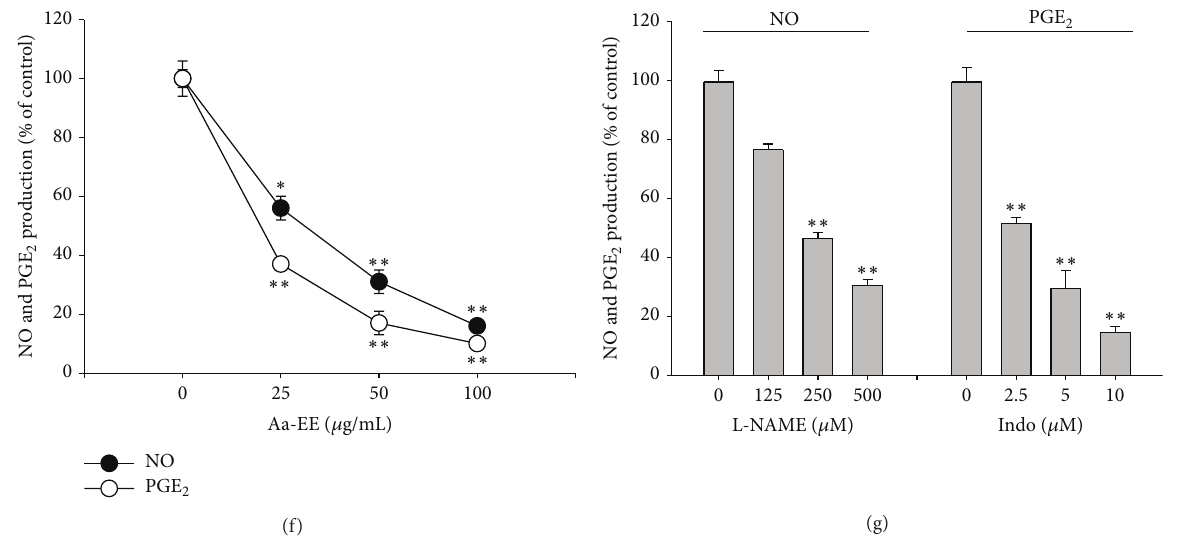
Figure 1: The effects of luteolin on the production of NO and PGE 2 in macrophages, and their viability. (a) Chemical structures of luteolin, eupatilin, and jaceosidin. ((b), (c), (e), (f), and (g)) RAW264.7 cells (1 × 10 6 cells/mL) were treated with LPS (1 𝜇 g/mL) in the presence or absence of luteolin, eupatilin, jaceosidin, Aa-EE, or standard compounds [indomethacin (Indo) and L-NAME] for 24 h. The supernatants were then collected, and the NO or PGE 2 concentrations in the supernatants were determined using the Griess assay or EIA. (d) RAW264.7 cells (1 × 10 6 cells/mL) were treated with luteolin for 24h. Cell viability was evaluated using the MTT assay. All data are expressed as the mean ± SD of experiments, which were performed with six samples. ∗ 𝑝 < 0.05 and ∗∗ 𝑝 < 0.01 compared to normal or control